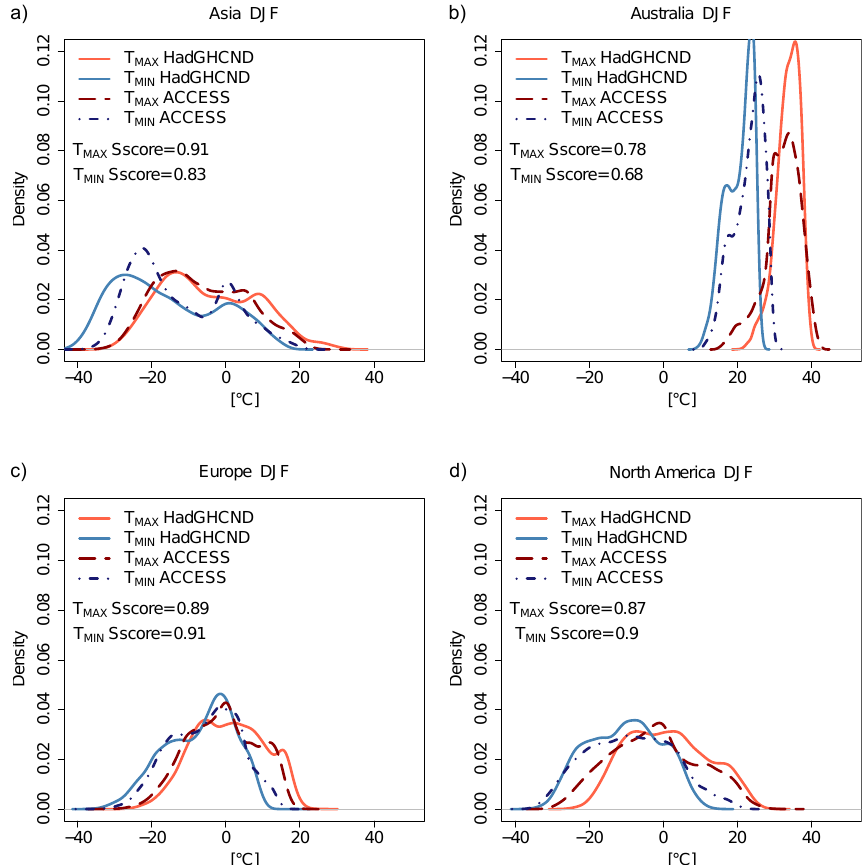
Fig. 9. T MAX and T MIN probability density functions for ACCESS1.3b and HadGHCND over Asia, Australia, Europe and North America for DJF (1951–2011) and skill scores for PDFs of T MAX and T MIN . The skill score is calculated by summing up the lower probability at each bin of two given PDFs, S score = P n minimum (Z m ,Z o ) where n is the number of bins used to calculate the PDFs and Z m and Z o correspond 1 to the frequency of values in a bin from the model and the observations,